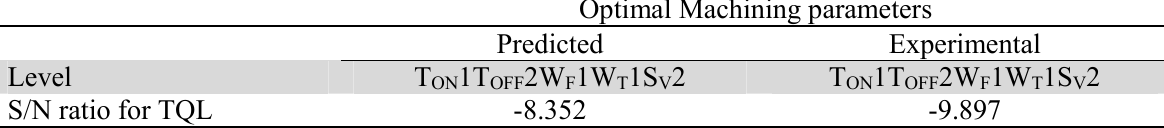
Result of Confirmatory test for TQL